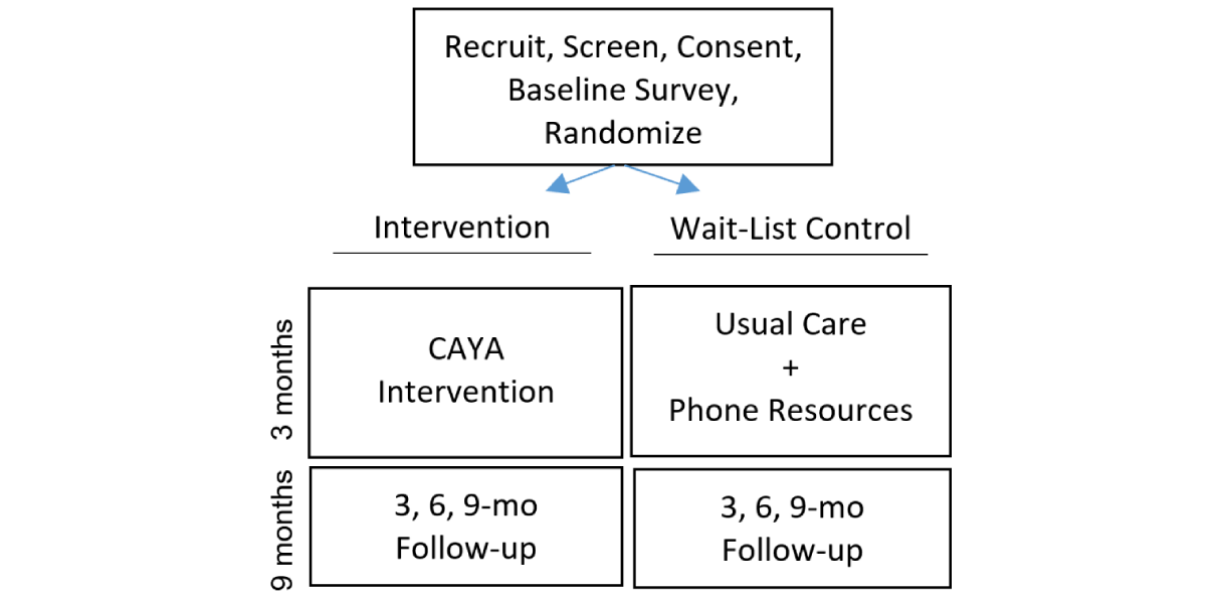
Figure 1. Study flow diagram. CAYA: Come As You